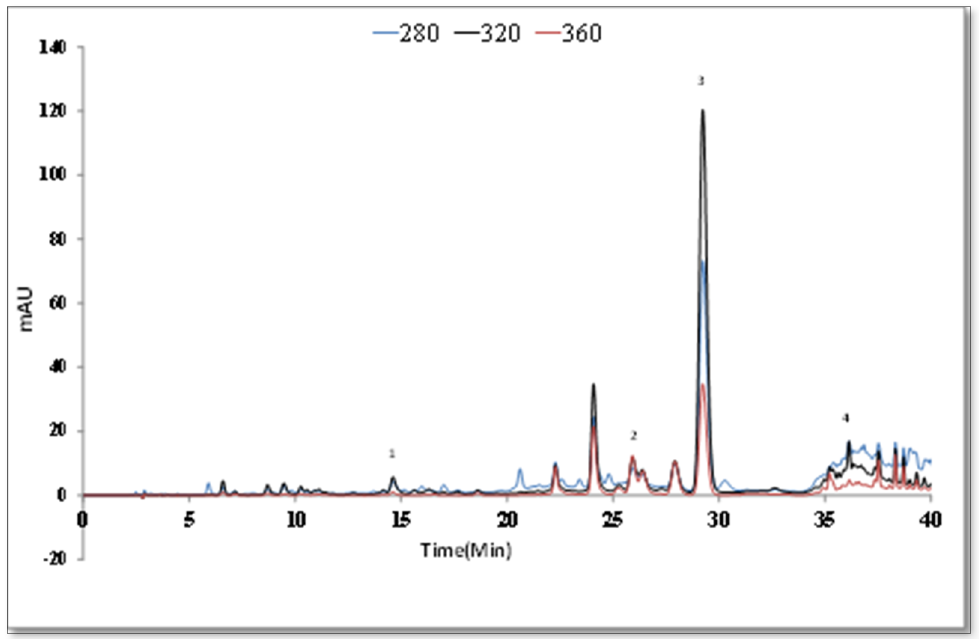
Figure 3. HPLC chromatogram of 70% MeOH extract of S. aramiensis. Table 5. HPLC results of S. aramiensis extract.